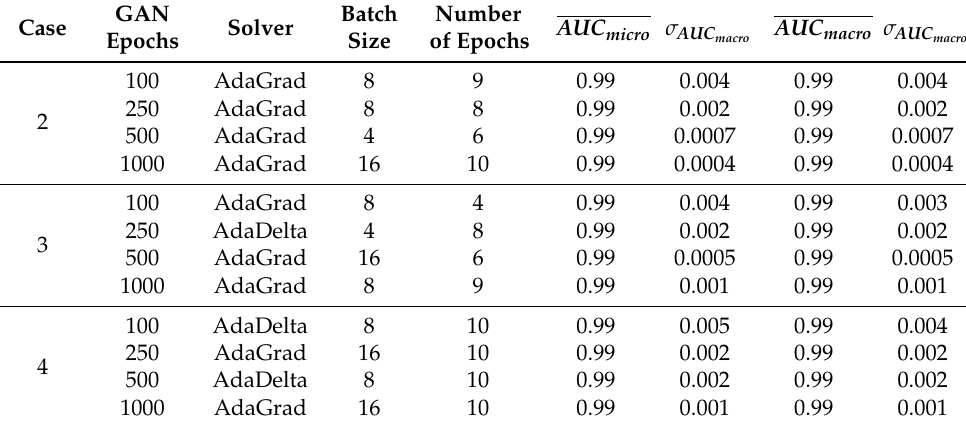
Table 7. Best results achieved with VGG-16